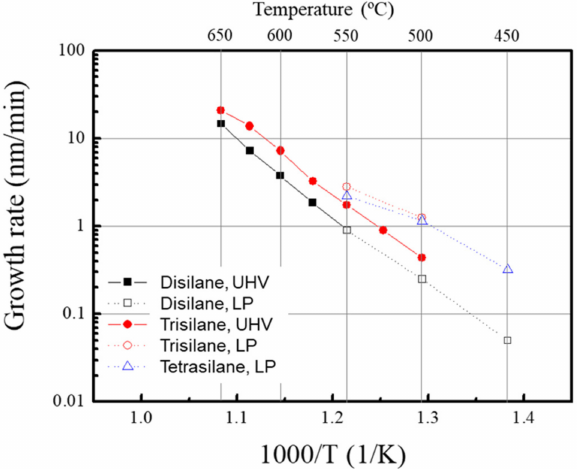
Figure 3. Arrhenius plot of high-order, silane-based Si epitaxy under UHVCVD and LPCVD con- ditions. The solid symbols and lines represent UHVCVD conditions, while the open symbols and dotted lines represent LPCVD conditions. The black squares, red circles, and blue triangles represent disilane, trisilane, and tetrasilane,